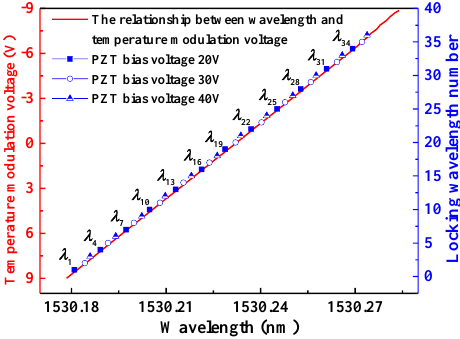
Figure 6. The acquired locking points in 3 scan periods with different PZT bias voltages of 20 V, 30 V and 40 V. and 40